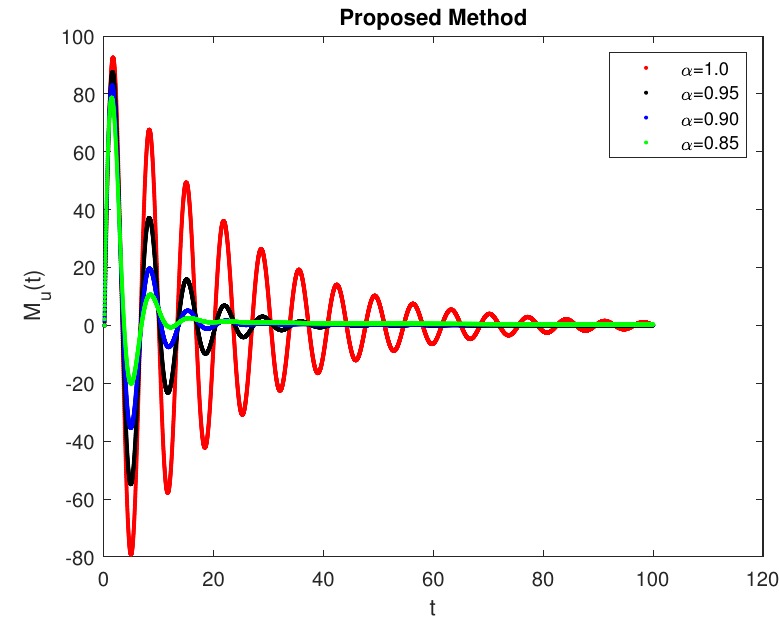
Figure 13: Numerical simulations for τ = 0.98 for Caputo derivative.